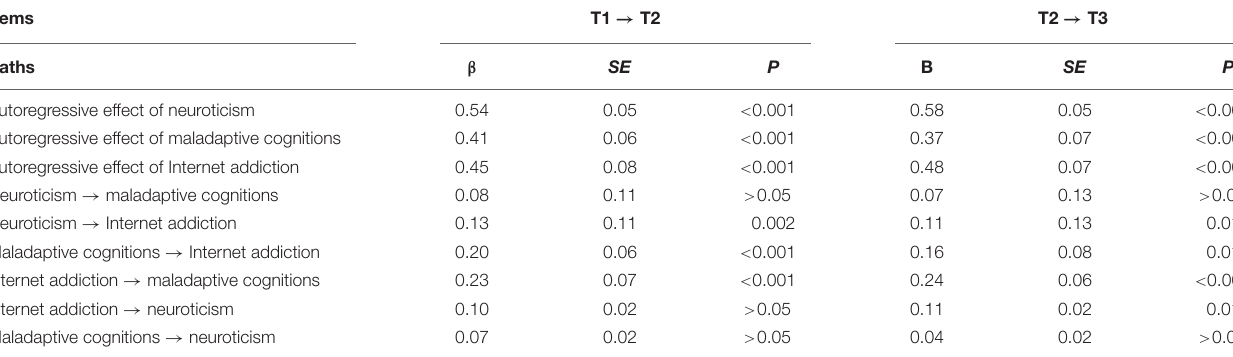
TABLE 5 | Regression coefficients of cross-lagged associations among agreeableness, maladaptive cognitions, and Internet addiction within M2. Items T1 → T2 T2 → T3 Paths β SE P Autoregressive effect of agreeableness Autoregressive effect of maladaptive cognitions Agreeableness → maladaptive cognitions Maladaptive cognitions → Internet addiction Internet addiction → agreeableness Maladaptive cognitions → agreeableness TABLE 6 | Regression coefficients of cross-lagged associations among conscientiousness, maladaptive cognitions, and Internet addiction within M3. Items T1 → T2 T2 → T3 Paths β SE P B SE P Autoregressive effect of conscientiousness 0.57 < 0.001 Autoregressive effect of maladaptive cognitions Autoregressive effect of Internet addiction < 0.001 Conscientiousness → maladaptive cognitions Maladaptive cognitions → Internet addiction